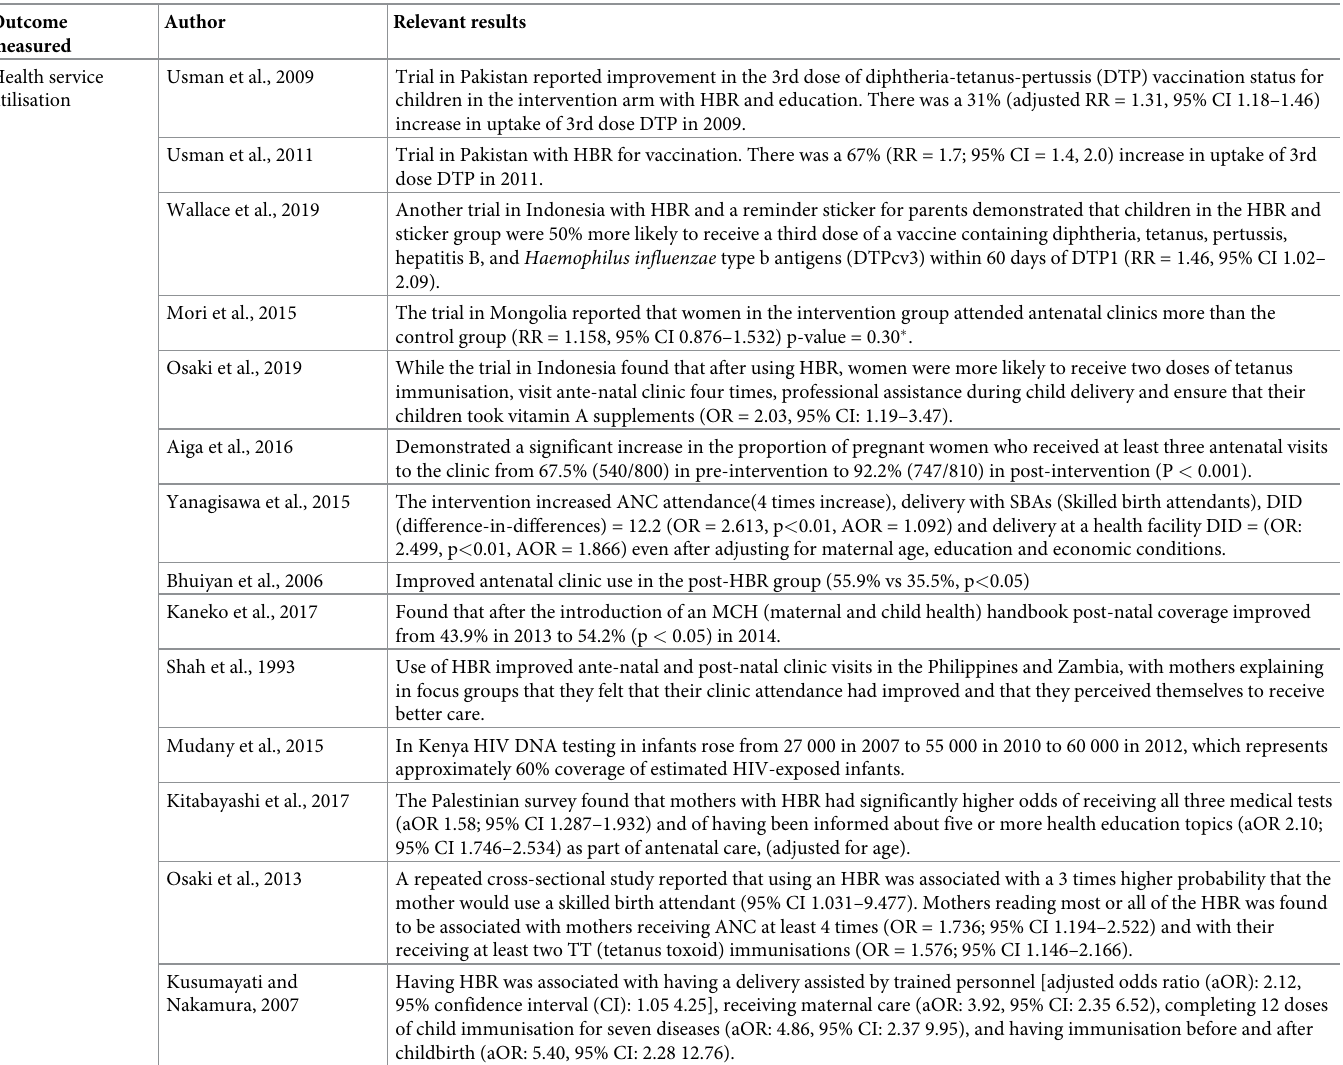
Table 4. Impact of HBR on health service